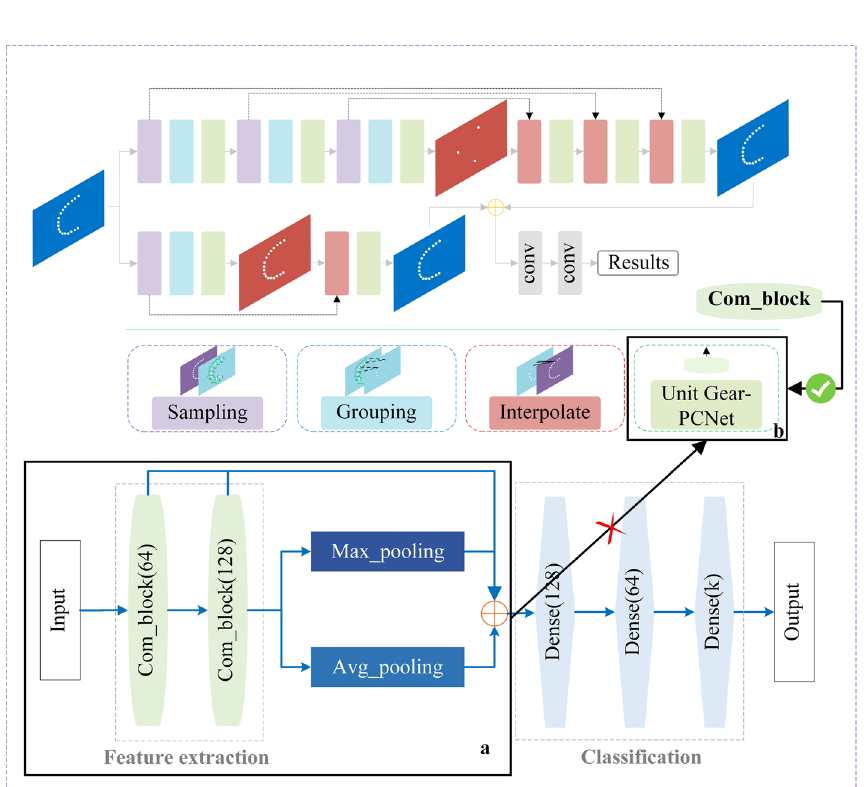
Fig. 8 Feature extraction module in Gear-PCNet/Gear-PCNet in Gear-PCNet +